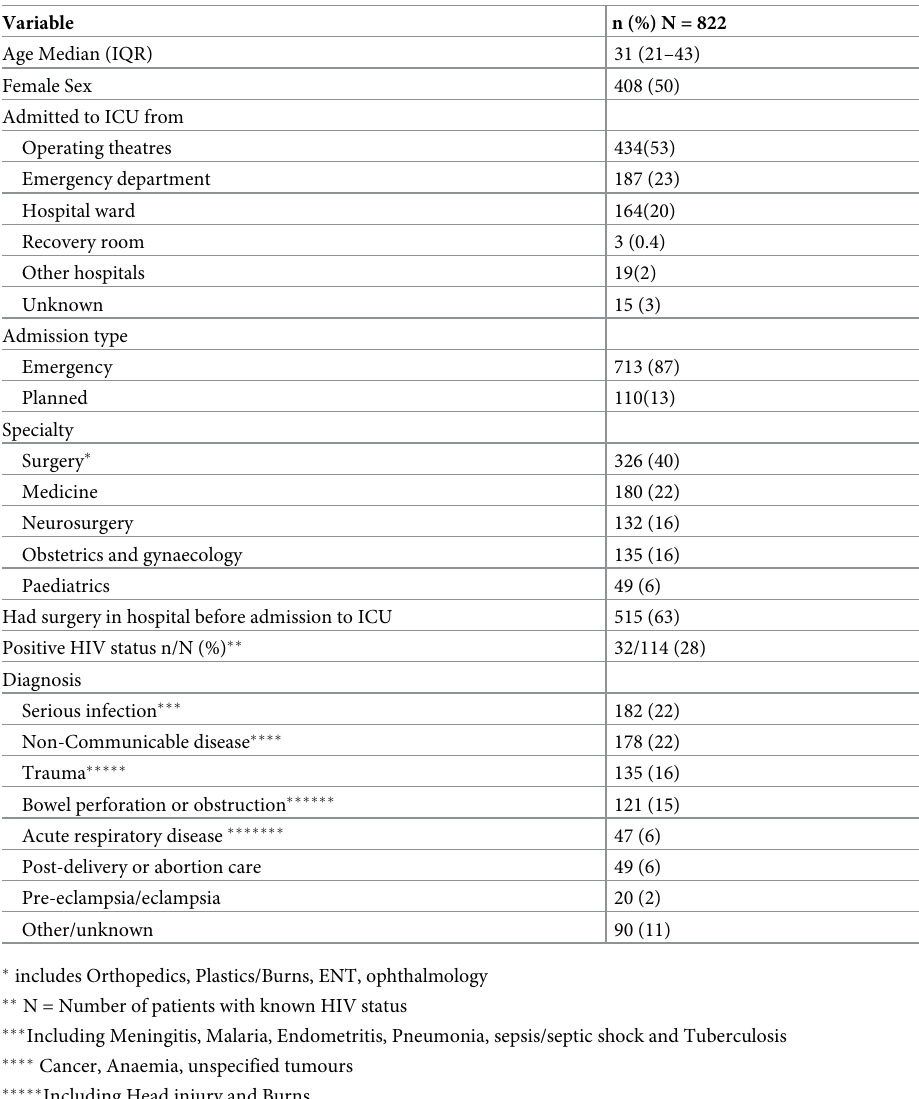
Table 1. Patient